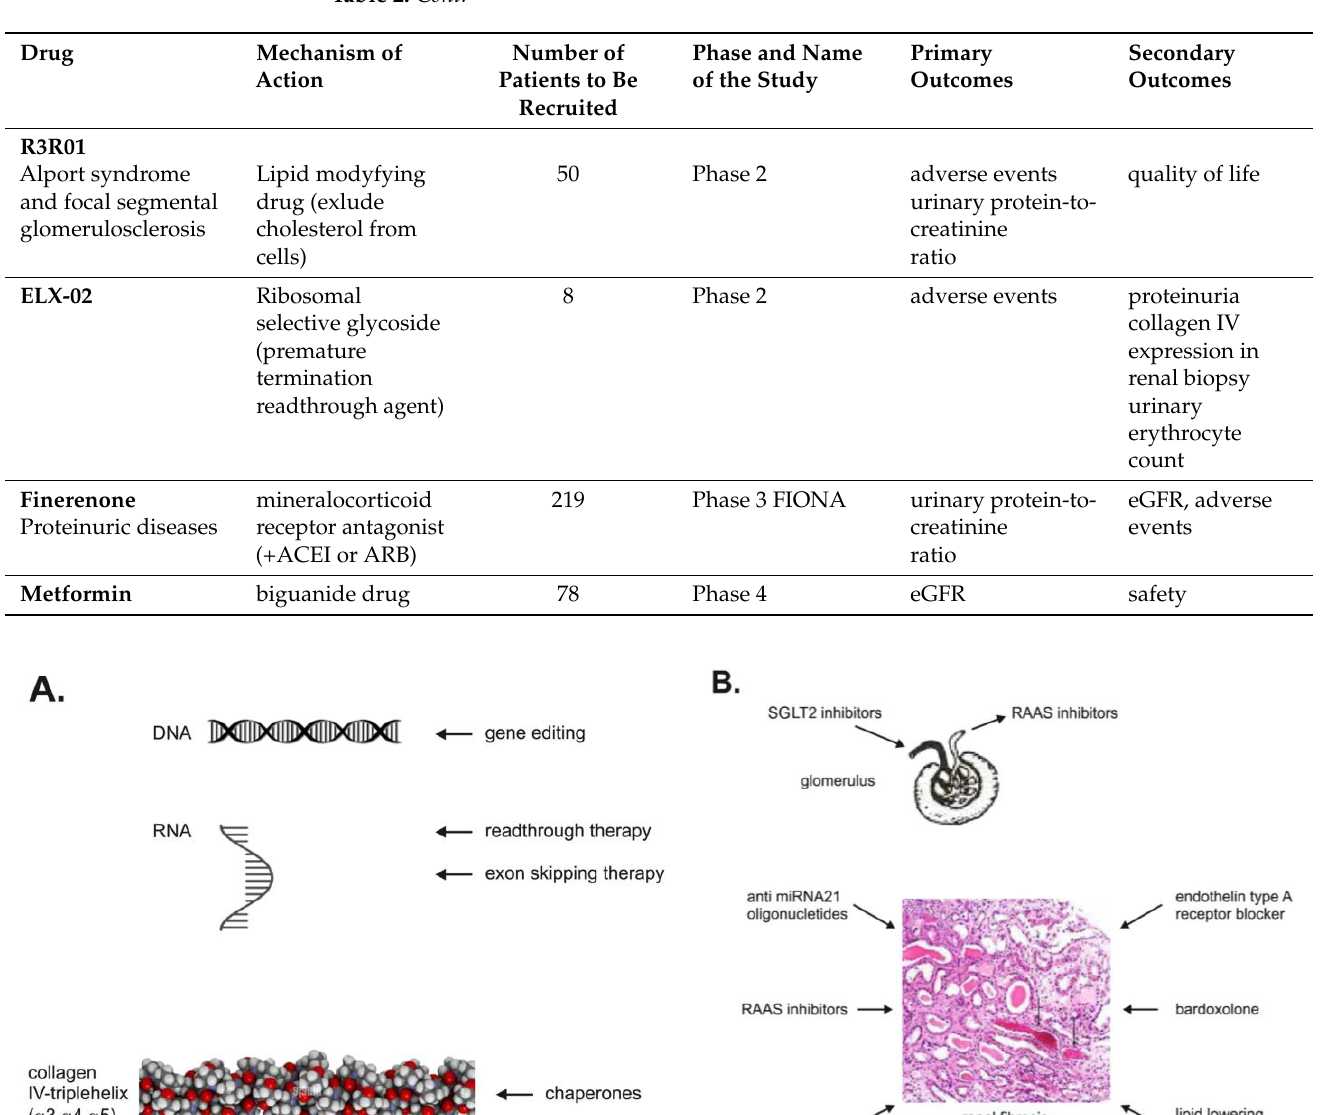
neys of Col4α3 knock-out mice [11]. Angiotensin converting enzyme inhibitor (ACEI) ram- ipril was studied in a mouse model with ARAS. Untreated animals died at 10 weeks; ram- ipril decreased proteinuria and kidney fibrosis and significantly prolonged survival [12].